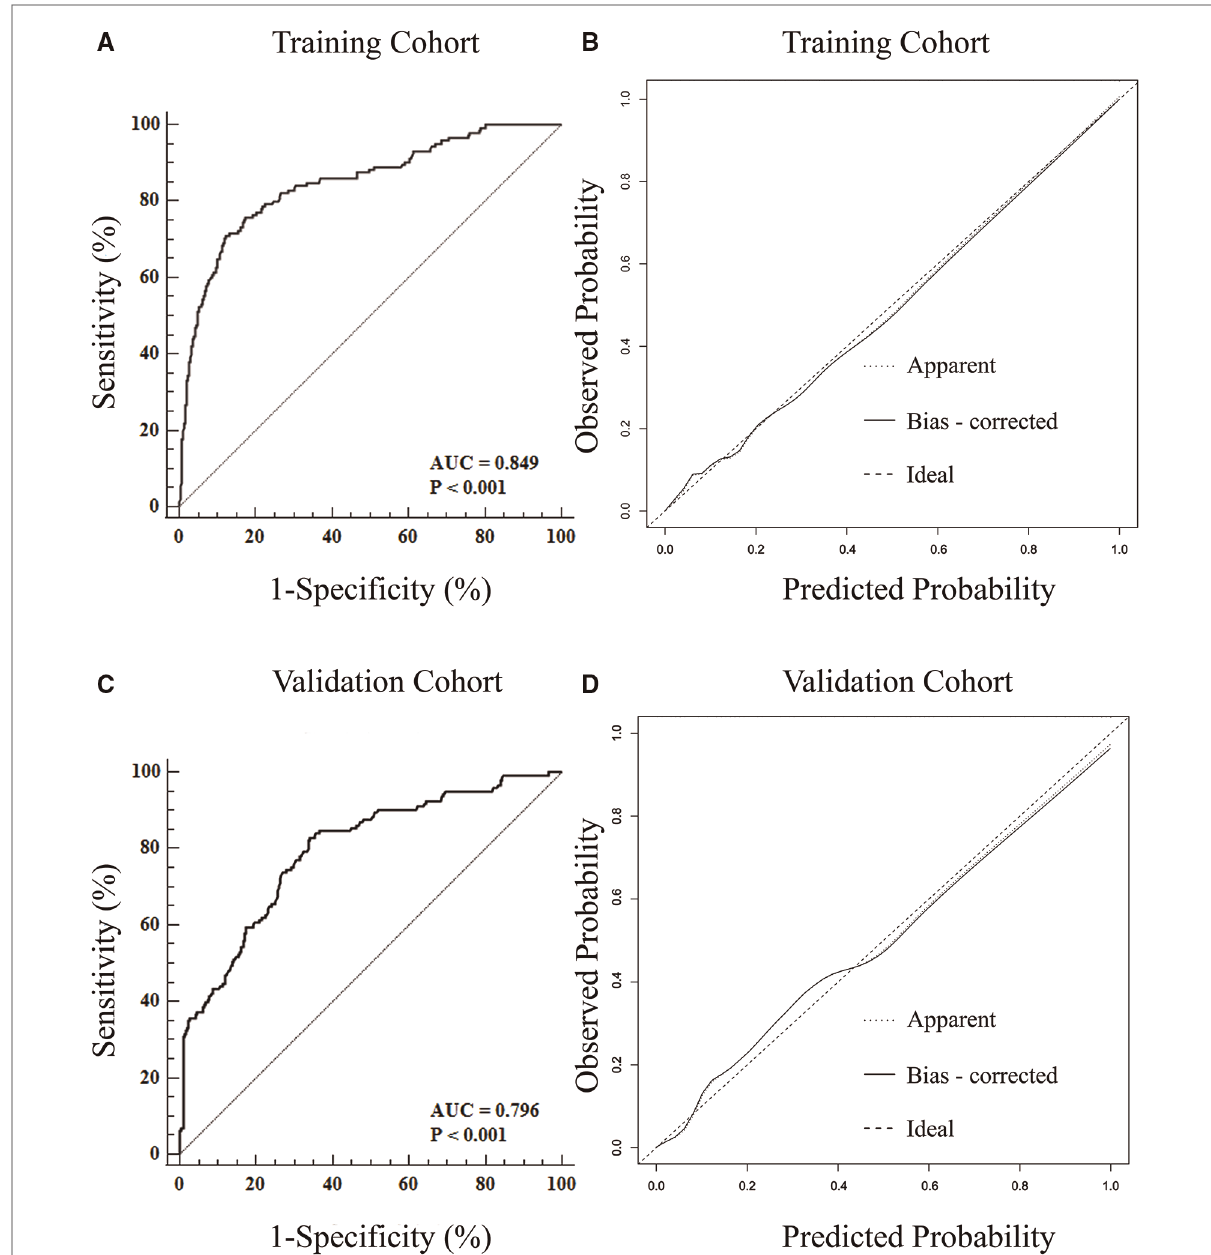
FIGURE 5 Discrimination and calibration for the nomogram in the training and validation cohorts. The AUC of ROC curves are 0.849 ( A ) and 0.796 ( C ) in the training and validation cohort, and both indicating good discrimination. The calibration curves indicate that the predicted probability of SVD failure matches the actual probability well in the training cohort ( B ) and validation cohort ( D ). SVD, spontaneous vaginal delivery; ROC, receiver operating characteristic; AUC, area under the